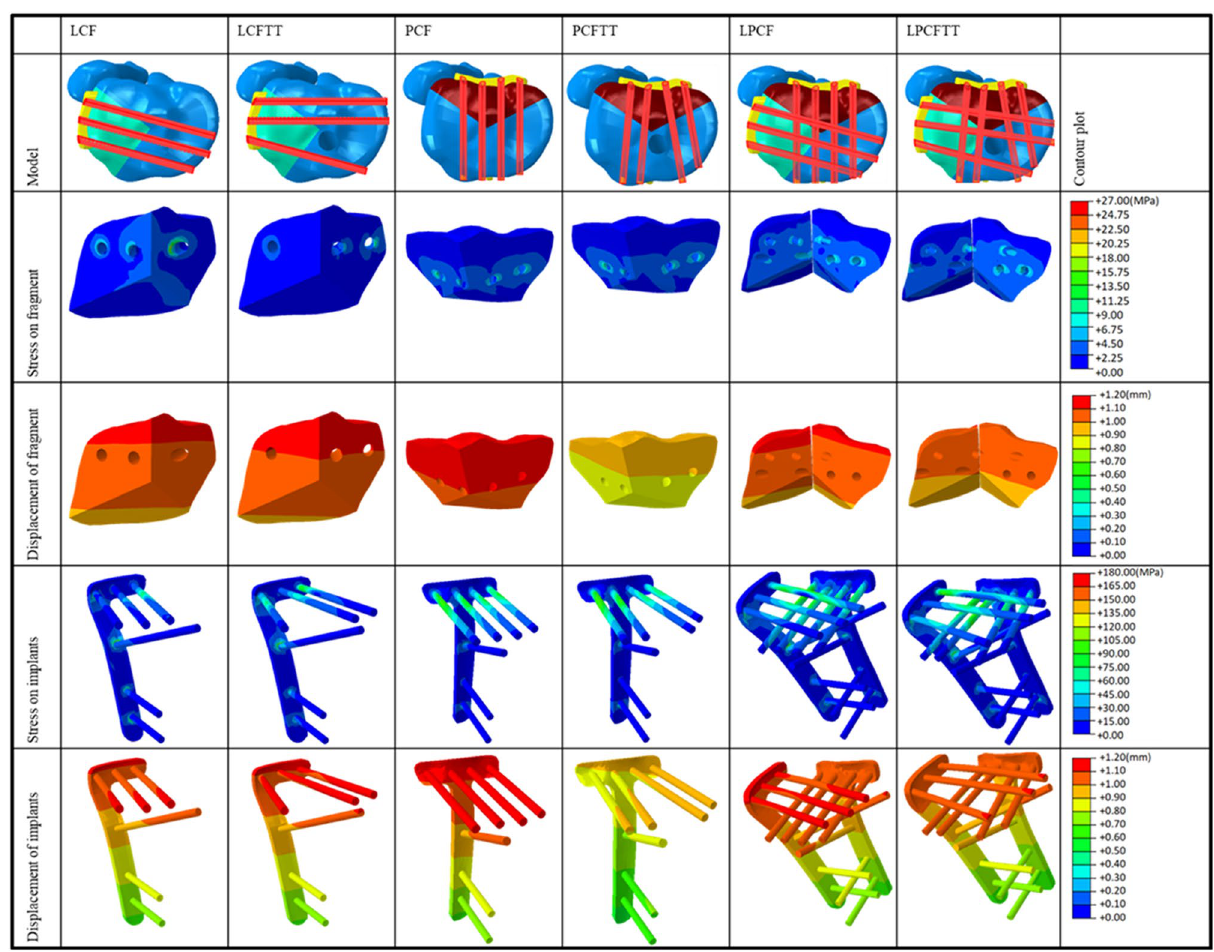
Figure 3. Corresponding plot contours of Von Mises stress and displacement of fragment and implants between fracture models with and without TT and deformation scale factor for each model was uniform and the value of it was ten (created by Abaqus 6.14, https ://www.3ds.com/zh/produ cts-servi ces/simul ia/produ cts/abaqu